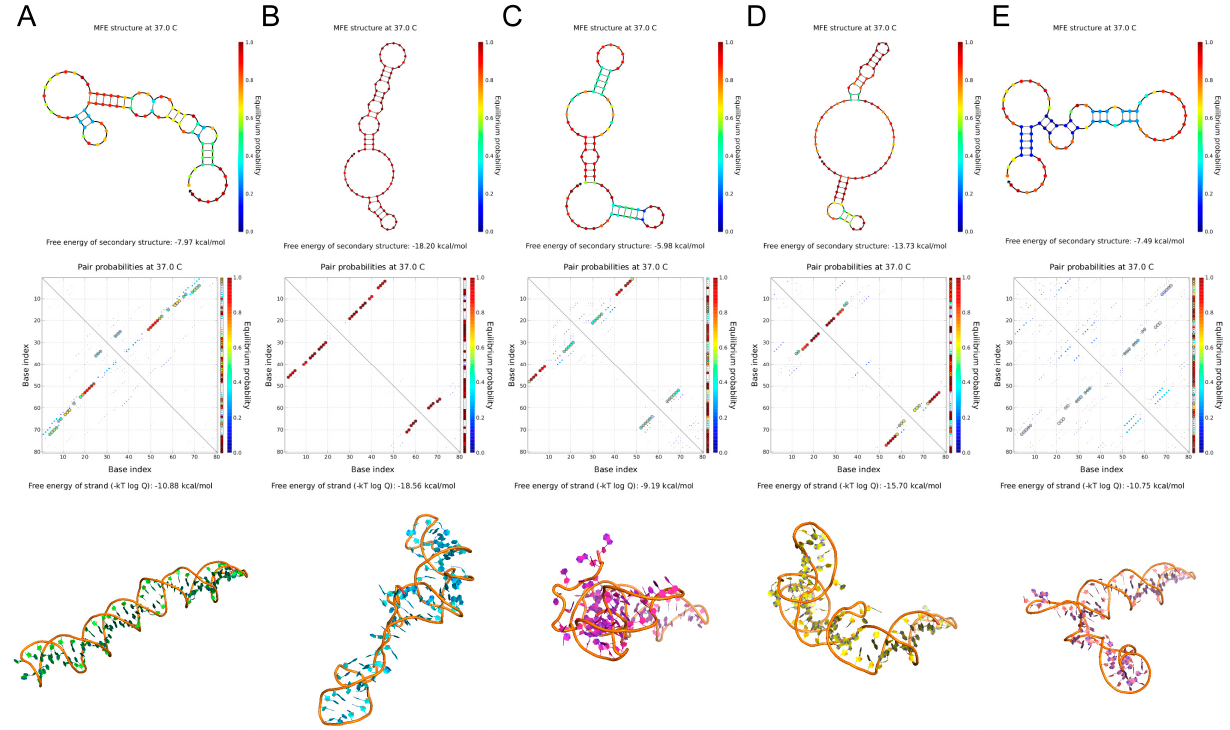
Figure 2. Secondary and tertiary structure prediction of candidate aptamers. ( A – E ) The secondary and tertiary structures of AptFAP-A1~AptFAP-A5 were predicted by the NUPACK software and the 3dRNA/DNA tertiary structure prediction method, respectively.